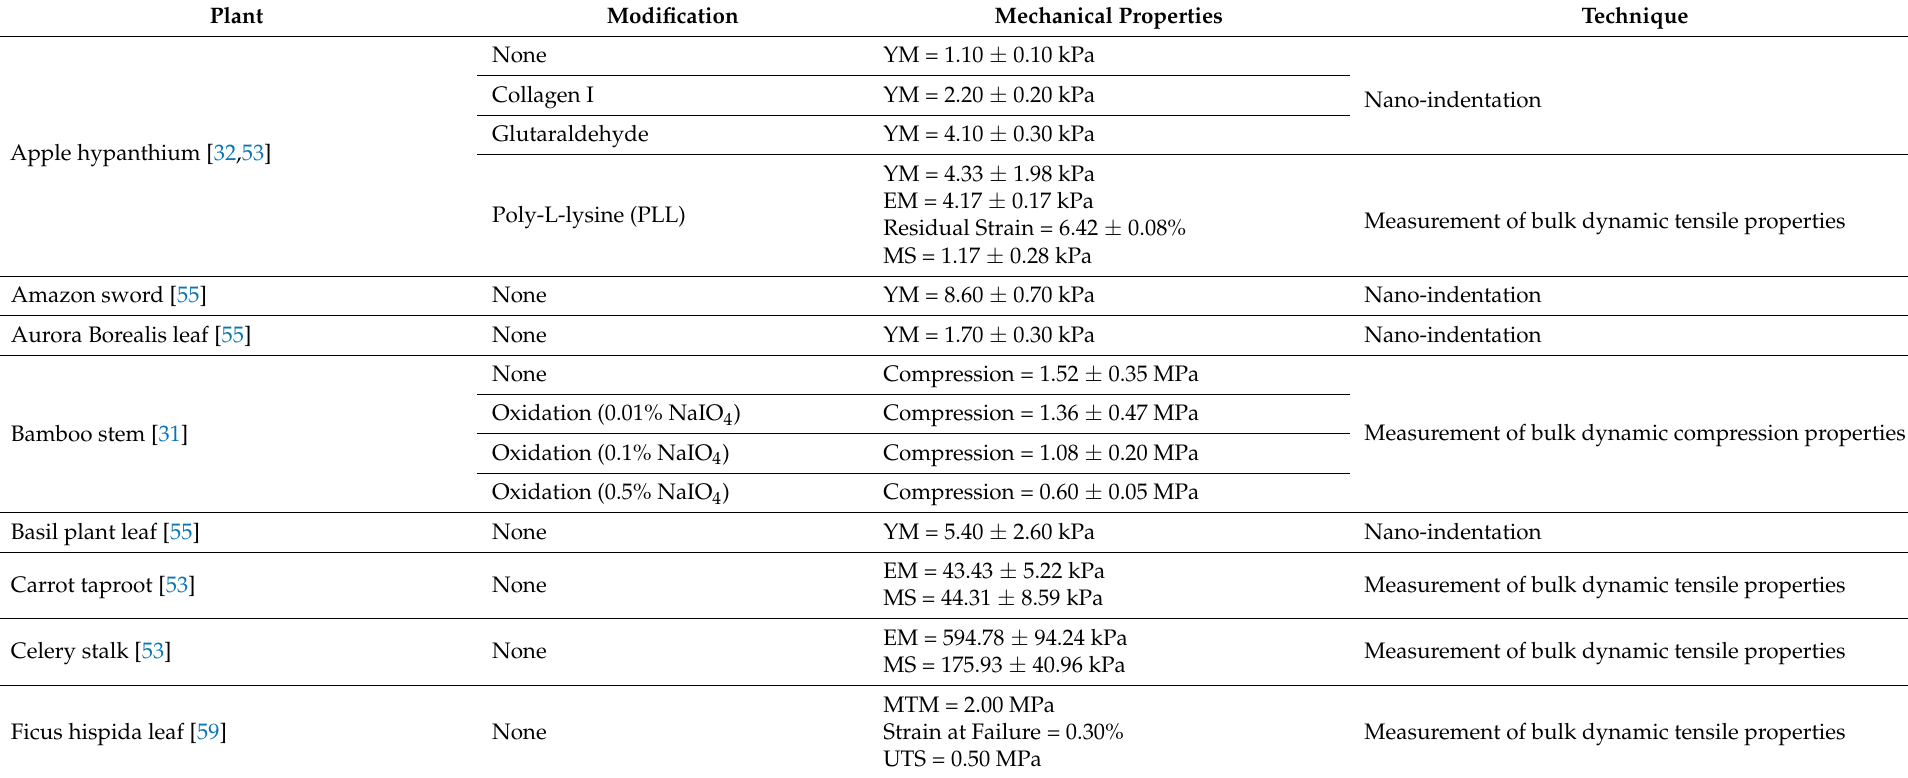
Table 2. Summary of the mechanical properties of decellularized plant tissues. EM, elastic modulus; MS, maximum stress; MTM, maximum tangent modulus; TS, tensile strength; UTS, ultimate tensile strength; YM, Young’s